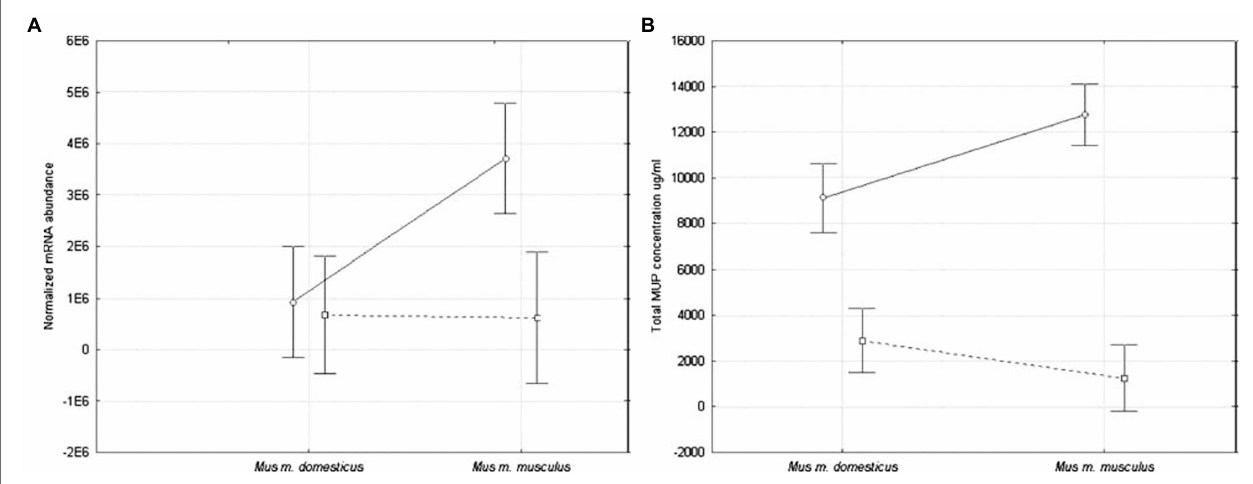
FIGURE 9 | MUP expression in two Mus musculus subspecies. MUP output was compared using (A) normalized hepatic MUP mRNA abundance, and (B) concentration of urinary MUP protein circles connected by solid lines show differences between males, and squares connected by dashed lines show differences between females of these subspecies (error bars show 95% confidence intervals). Figure used with permission from Stopková et al. (2007).